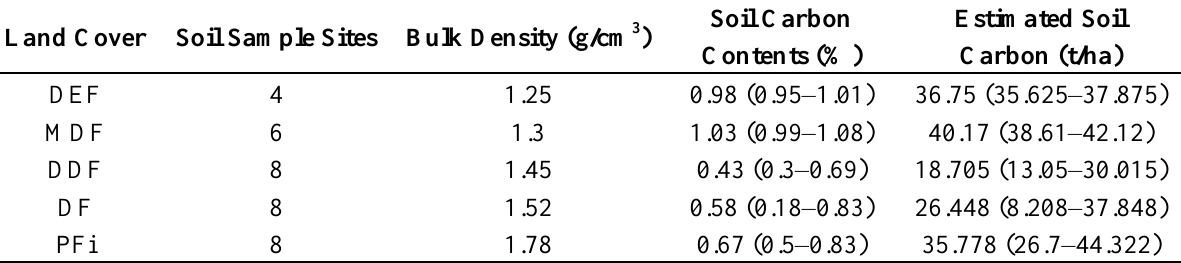
Table 6. Average soil carbon content by land-cover type.